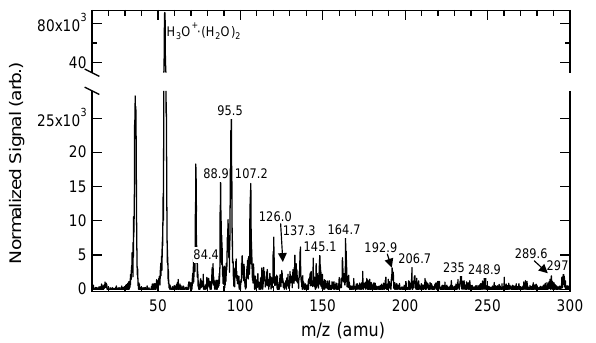
Figure 8. Aerosol-CIMS spectra of atomized solutions of 2 M acetaldehyde/MG (1:1) Fig. 8. Aerosol-CIMS spectra of atomized solutions of 2M ac- in 3.1 M AS. See the text for details of sample preparation and analysis. Negative-ion etaldehyde/MG (1:1) in 3.1MAS. See the text for details of sample mass spectrum obtained using I - as the reagent ion. preparation and analysis. Negative-ion mass spectrum obtained us- ing I − as the reagent ion.